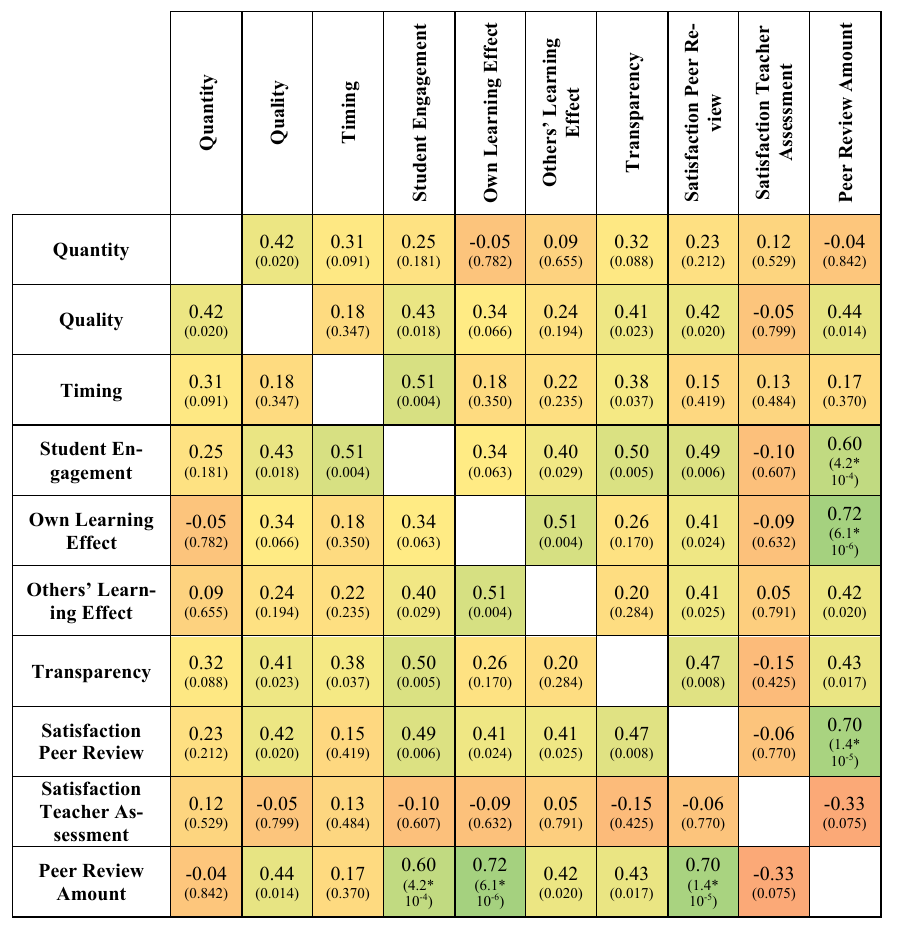
Table 2. Spearman correlation coefficients of analyzed learning factors (REST